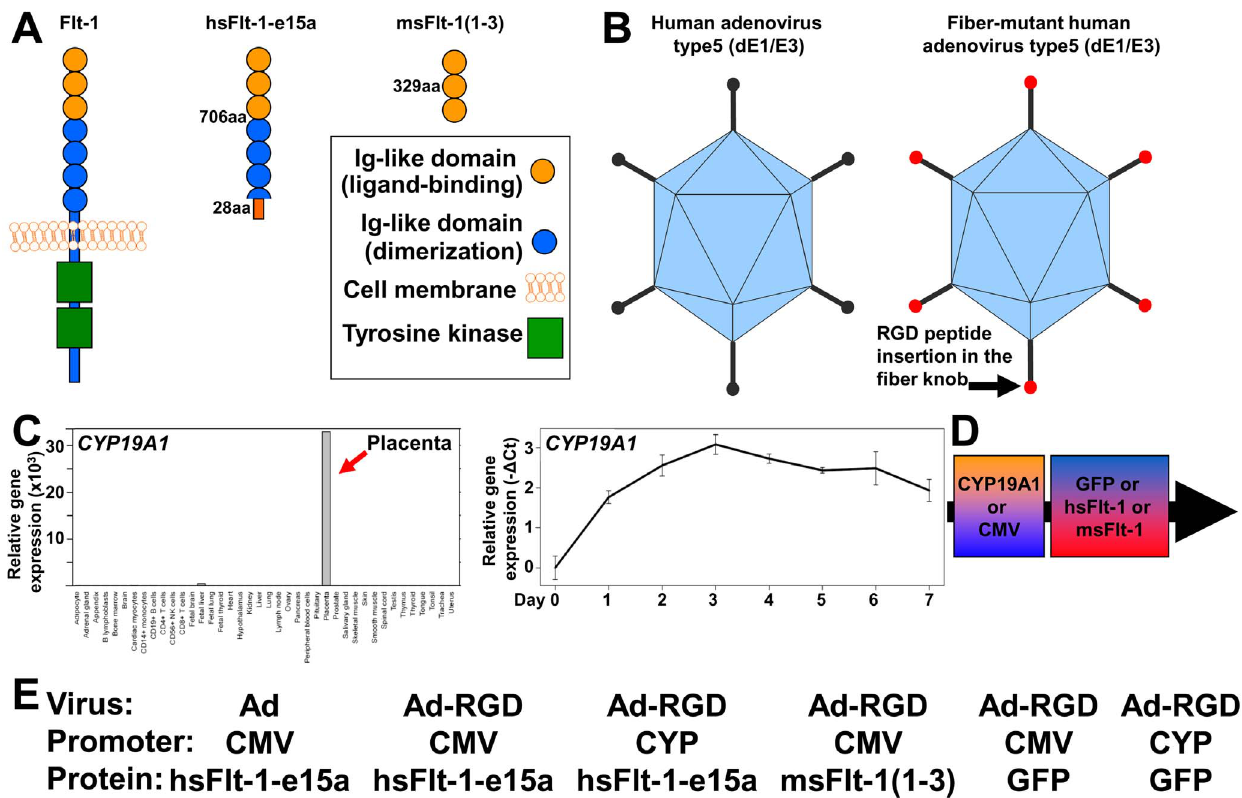
Figure 2. The development of viral constructs for the various treatment groups. ( A ) Human and mouse Flt-1 contains seven extracellular Ig- like domains and an intracellular tyrosine kinase, from which the first three Ig-like domains are important in ligand-binding, while the 4–7th Ig-like domains in receptor dimerization. The most abundant placental sFlt-1 variant in humans, sFlt-1-e15a, contains six Ig-like domains and a unique C- terminus encoded by exon 15a, which is located within a primate-specific AluSeq retrotransposon. The truncated mouse sFlt-1 mutant [msFlt-1(1-3)] contains only the first three Ig-like domains of Flt-1. ( B ) Besides the replication deficient human adenovirus Type5 (dE1/E3), ‘‘RGD fiber-mutant’’ adenoviruseswere also used. ( C ) Besides the CMVpromoter that hasa strongpromoter activity,the human CYP19A1 promoterwasalso used. CYP19A1 is strongly and predominantly expressed in the placenta among 40 human tissues (left), and its expression increases during trophoblast differentiation (right). Relative gene expressions are shown on the Y-axes. ( D–E ) Various combinations of viruses, promoters and transgenes used in this study.